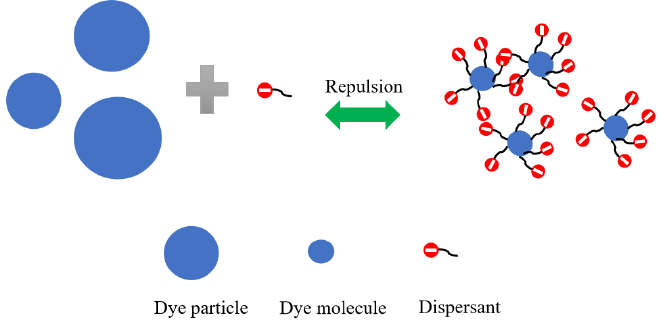
Figure 8. The dispersion mechanism of NNO/MF for disperse dye in silicone solvent dyeing system.